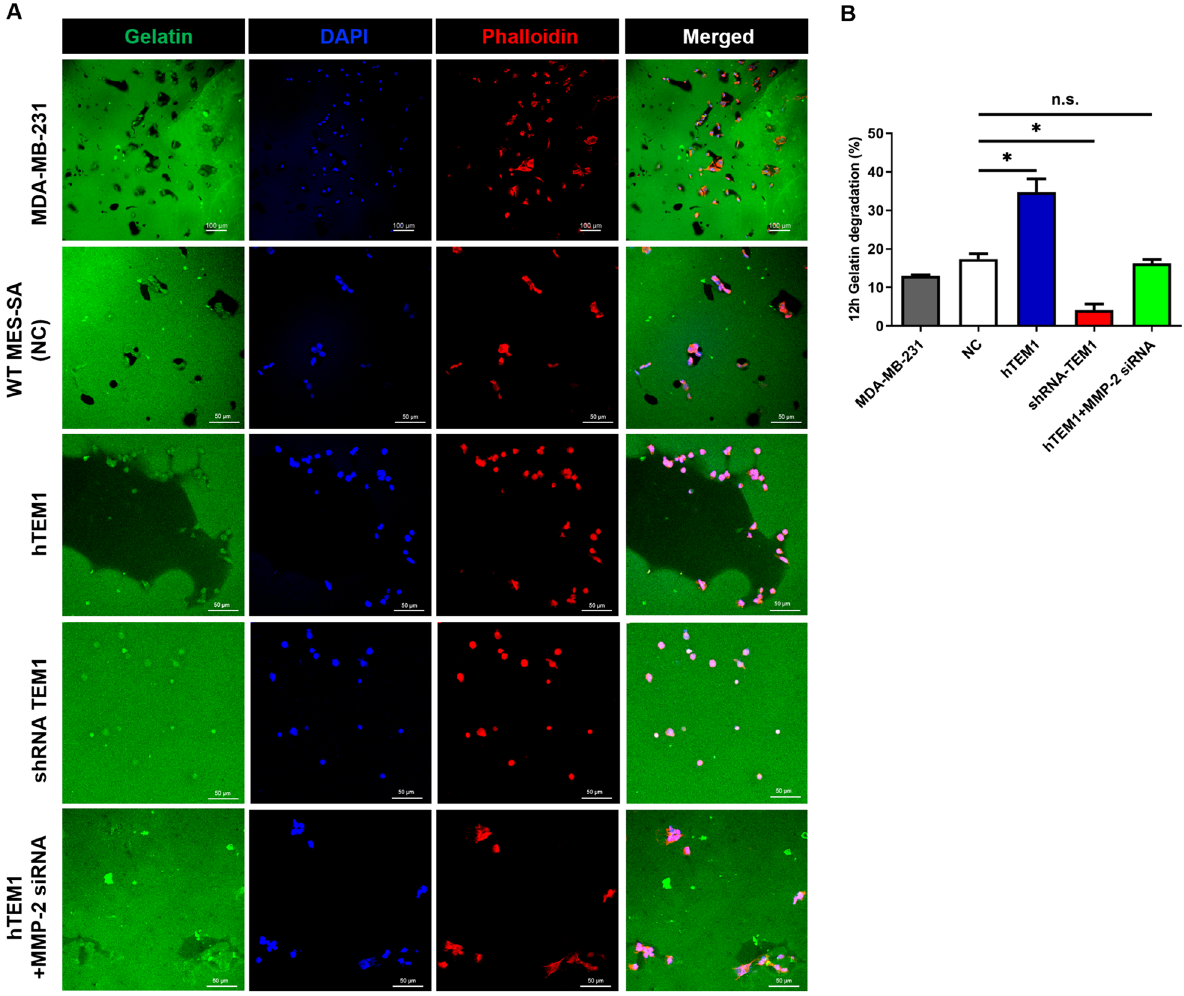
Fig. 5 ( A ) Gelatin degradation assays of MDA-MB-231, WT MES-SA (NC), hTEM1 MES-SA, shTEM1 MES-SA and hTEM1 MES-SA knocked down MMP-2 expression by MMP-2 siRNA (hTEM1 + MMP-2 siRNA) after 12 h. MDA-MB-231 served as positive control. Pool-like areas of degrada- tion in gelatin matrix formed around hTEM-MES-SA cells. Immunofluorescence staining of FITC- conjugated gelatin (green), Phalloidin (red), nuclei (blue), and merged images. ( B ) Quantification of gelatin degraded area (n = 10) by Image J. Data are presented as mean ± standard deviation (SD). *, P < 0.05 in Student t -test; n.s., none-sense, P > 0.05; Scale bar, 100 μm or 50